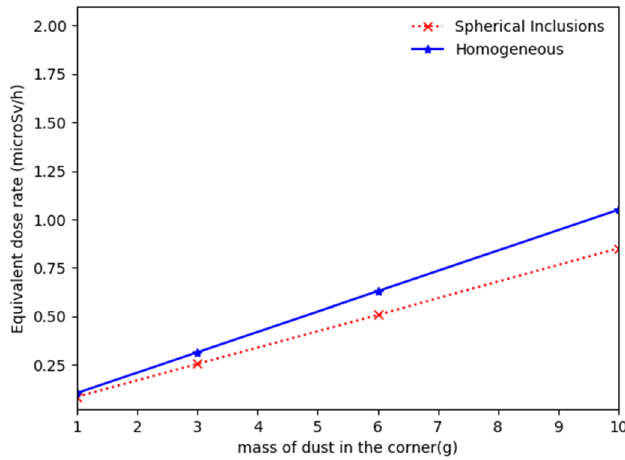
Fig. 9. Spherical inclusion model, neutron simulation with spheres with a fi xed constant radius of 0.05 cm and a constant density of 6.6 g/cm 3 with variable packing fraction (PRSD are inferior to